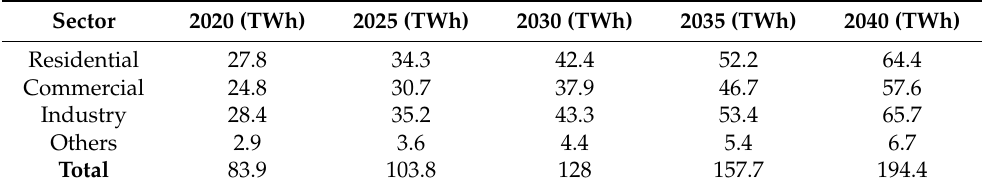
Table 1. Energy demand by sector 2020–2040